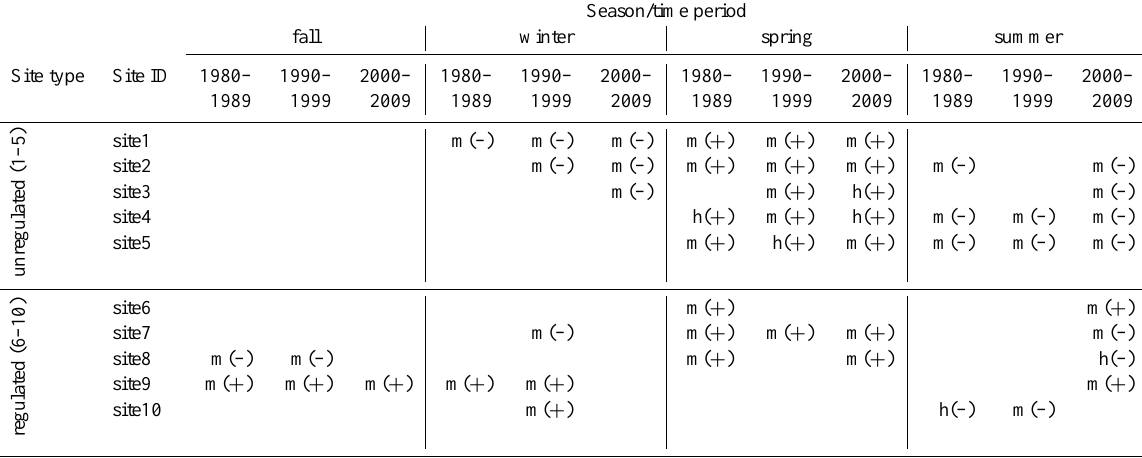
Table 2. Magnitude and direction of the value of skewness in probability distributions of daily minimum stream temperature by season and decade at unregulated (sites 1–5) and regulated (sites 6–10) streams. Symmetric distributions are not shown. m: moderately skewed; h: highly skewed; ( − ) : negatively skewed; ( + ) : positively skewed (see Tables S1–S3 for more details).